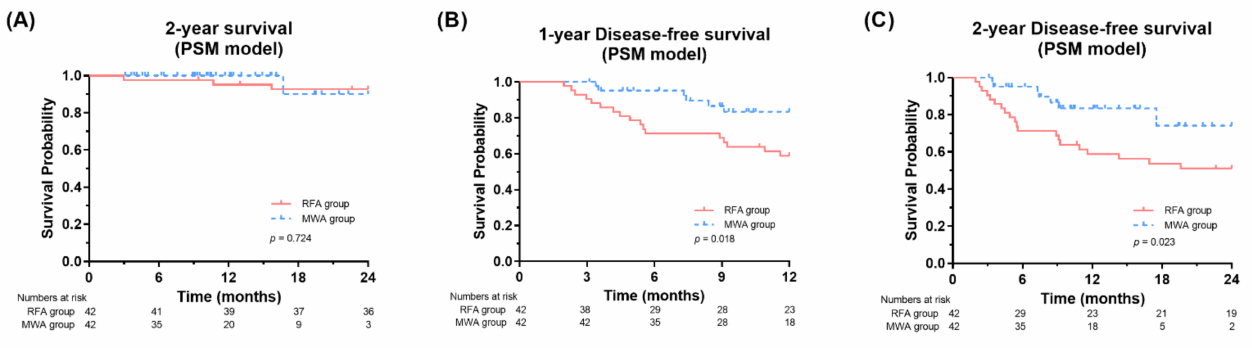
Figure 4. Survival and disease-free survival curves according to treatment modalities in the propensity-score matched cohort ( A – C ). RFA, radiofrequency ablation; MWA, microwave